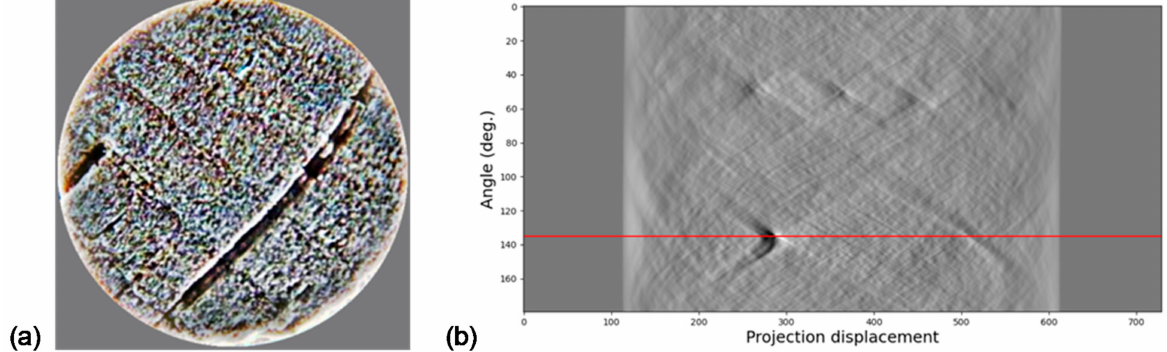
Figure 3. ( a ) Image; ( b ) Radon Transform (RT)